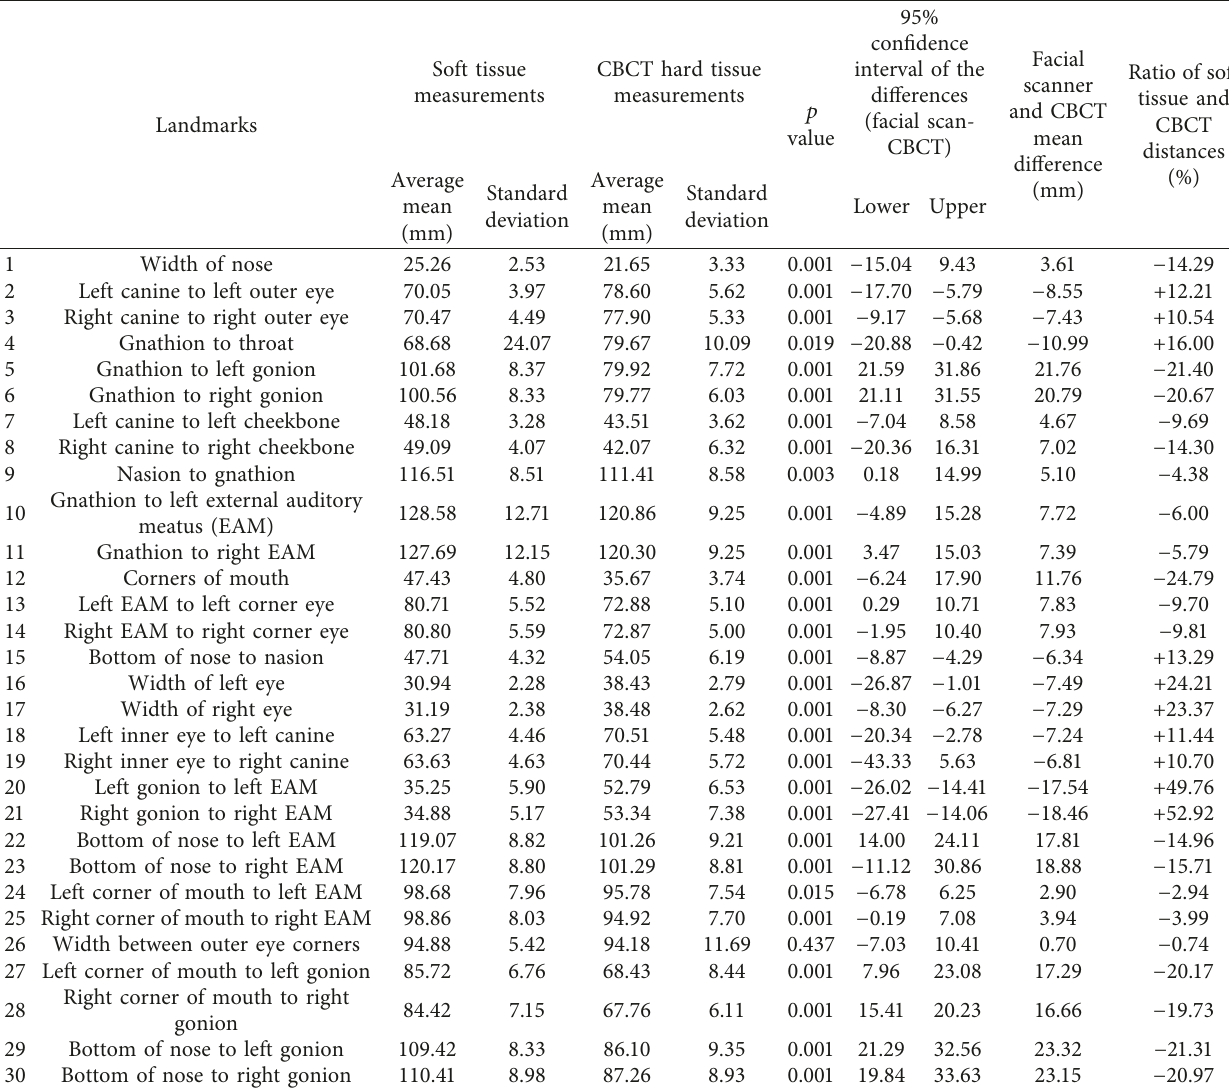
Table 3: Statistics of soft tissue distances and their CBCT equivalents, including average mean measurements, standard deviation, the difference between the average mean measurements, and the ratio of the CBCTdistances to the soft-tissue distances in percentage format, p values, and 95% confidence intervals of the differences between the facial scan and